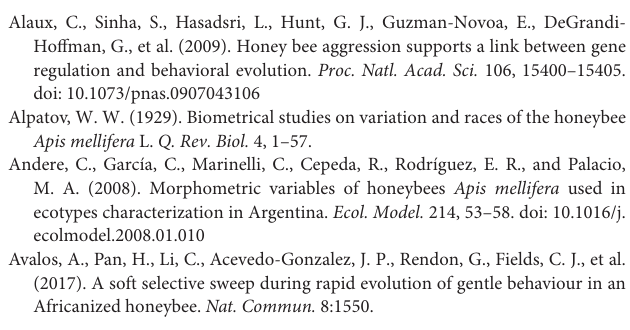
Supplementary Table 1 | Characteristics of Leales (LE) and Famaillá (FAM) colonies in the mid-season. Supplementary Table 2 | Student’s T -test for morphometric variables between apiaries (FAM and LE). ∗ Only variables with significant results ( P < 0.05)